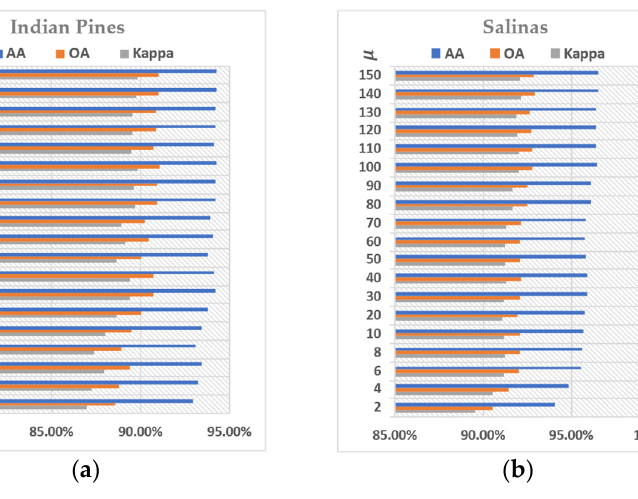
( c ) Figure 11. Classification performance of the SVM on the raw data, the average fusion data, and the output feature blocks of the first and second stages for the three datasets. ( a ) Indian Pines; ( b ) Salinas; ( c ) Houston University 2018. 5. Conclusions To improve classification performance and reduce the time cost, this article innova- tively proposes an efficient two-staged FE method based on TV for HSI. Based on different solutions of anisotropic and isotropic models, it successively completed the extraction of multi-scale structure information and detail smoothing enhancement of HSI, yielding dis- tinguished classification performance. In addition, this design has no complex framework nor a redundant loop, which greatly reduces computational overhead. When compared with many state-of-the-art algorithms, our method can significantly outperform others in classification performance and computing time, especially achieving better results in most